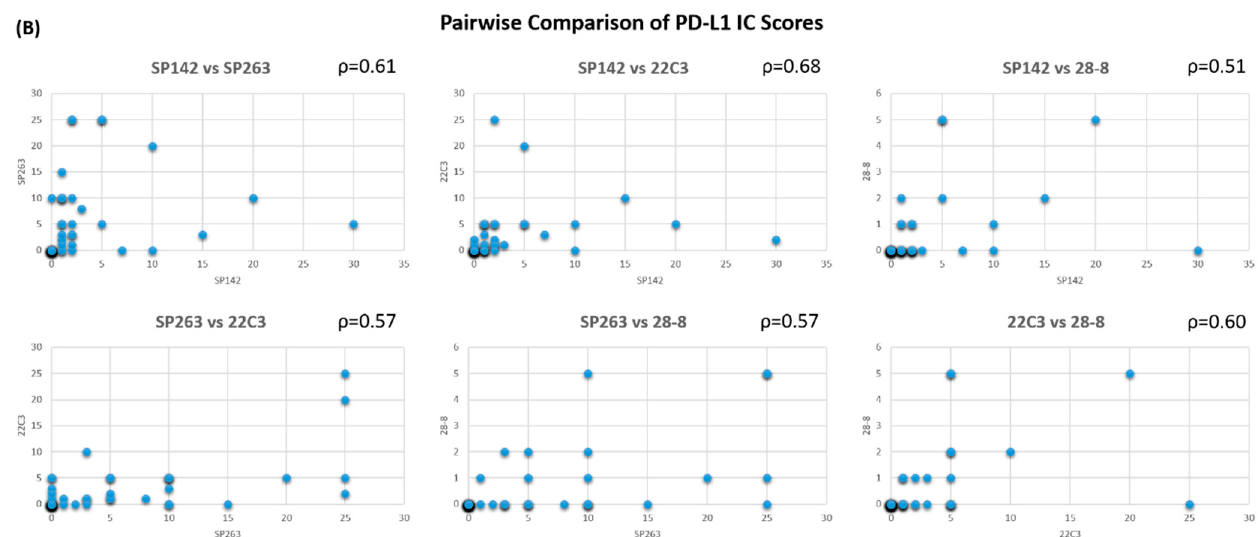
Figure 2. Pairwise comparison and correlation of ( A ) TC scores and ( B ) IC scores between clones, with the Spearman’s rank correlation coefficient in the upper right corner of each plot.